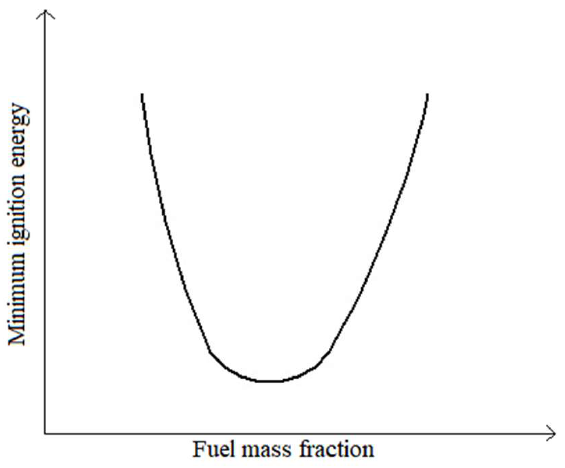
Figure 9. Variation of the MIE with the volume fraction of a